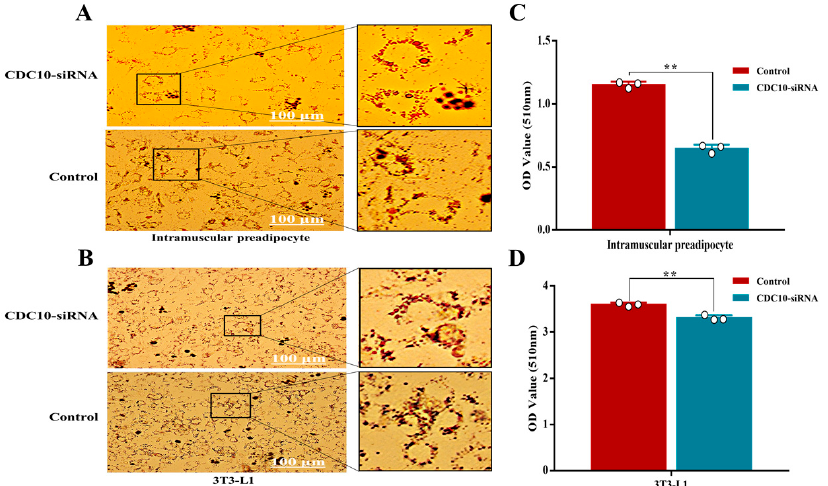
Figure 7. The effect of CDC10 knockdown on the differentiation of bovine intramuscular preadipocyte (BIMP) and 3T3-L1 cells was detected by Oil Red O staining. BIMP and 3T3-L1 cells were transfected with CDC10 -siRNA for 9 d during differentiation. ( A , B ) Oil Red O staining. ( C , D ) Oil Red O relative absorbance. Values are expressed as mean ± SEM ( n = 3). ** p < 0.01.